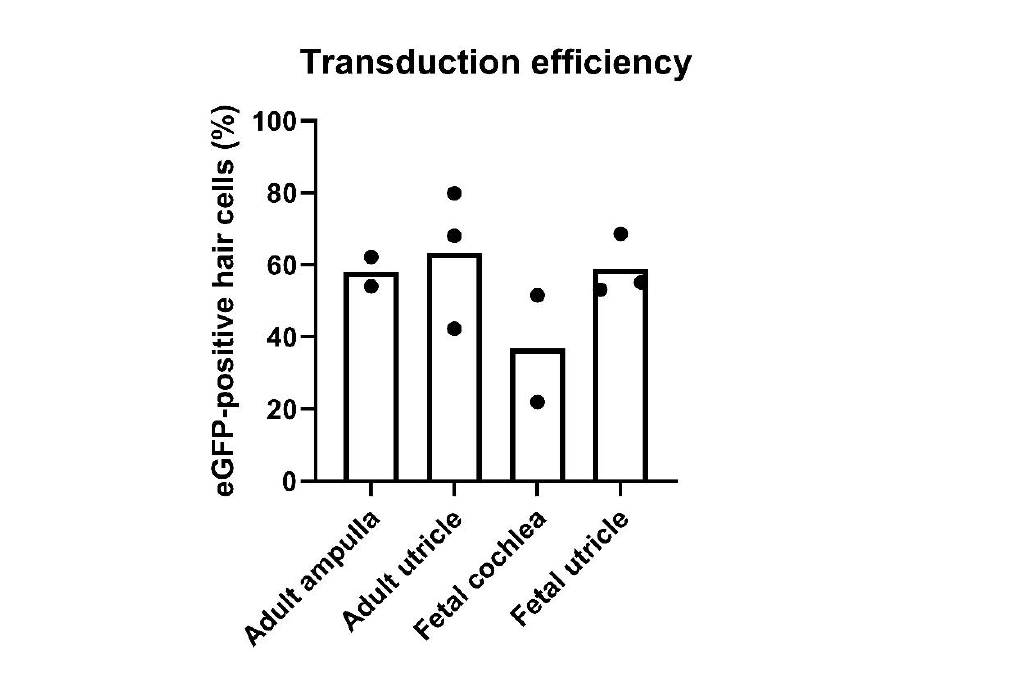
Figure 7. Transduction efficiency. The percentage of eGFP-positive hair cells was quantified by three blinded investigators. Cell counts on adult specimens were carried out on data from two ampullas and three utricles. Cell counts on fetal specimens were carried out on data from two cochleas and three utricles. Each black dot represents the mean of three individual cell counts. Bars represent the mean for each end organ, as indicated on the x-axis. eGFP-positive hair cells (%): adult ampulla, 58%; adult utricle, 63%; fetal cochlea, 37%; fetal utricle, 59%.